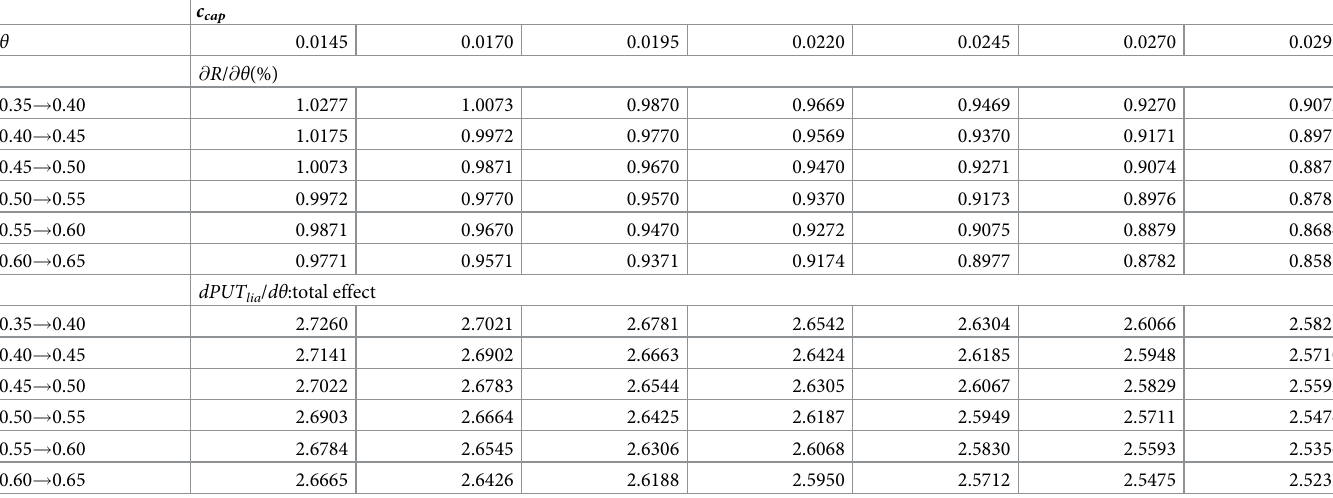
) to green loans ( θ ) at various levels of c lia